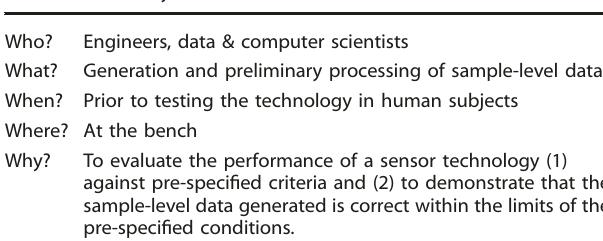
Table 2. Summary of veri fi